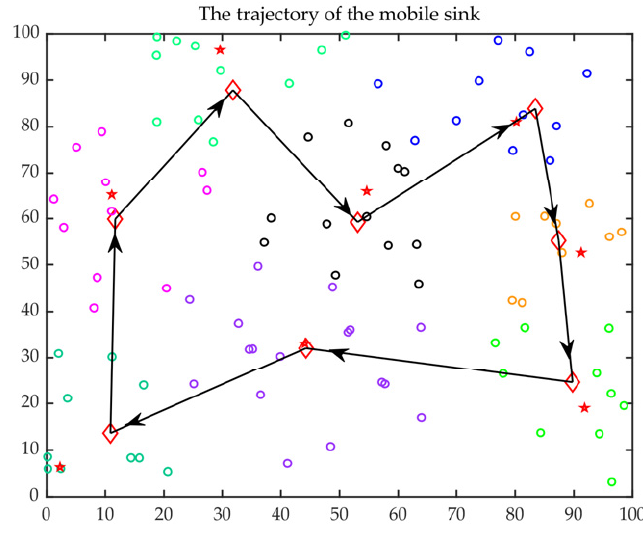
Figure 14. The optimal trajectory of MS.